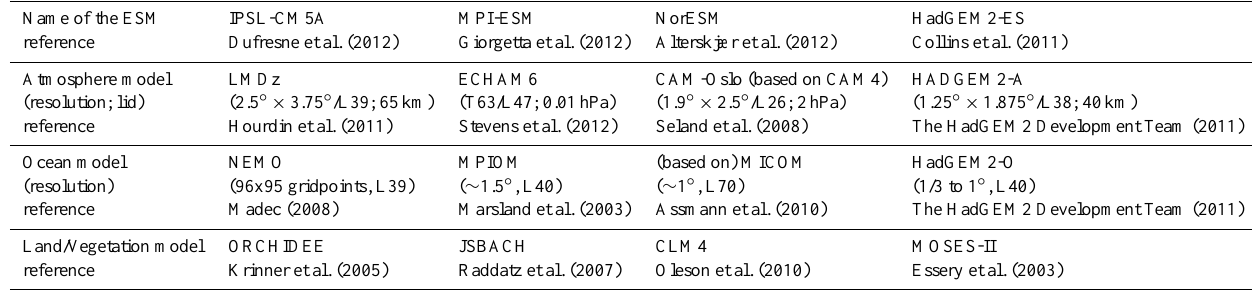
Table 1. Main characteristics of the participating ESMs.